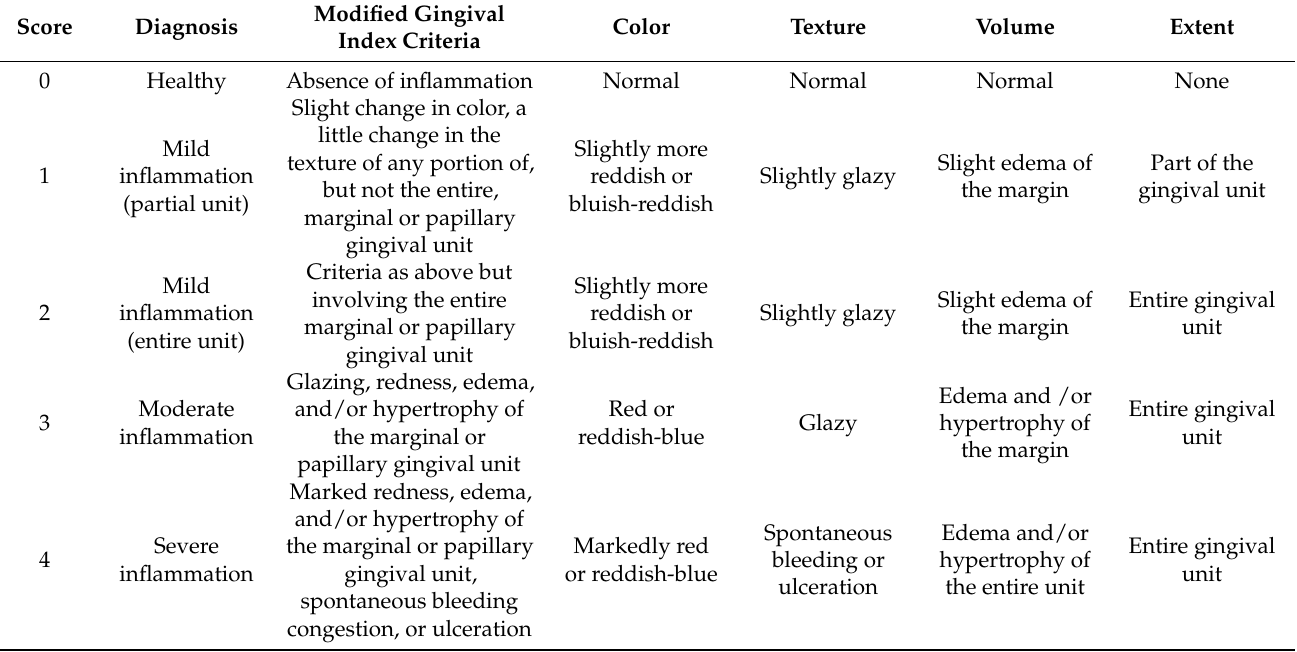
Table 1. Modified gingival index scoring system [37].